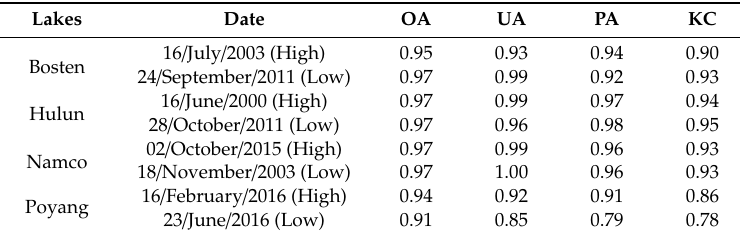
Table 3. Validation of MODIS-based classification results using Landsat-based reference results.